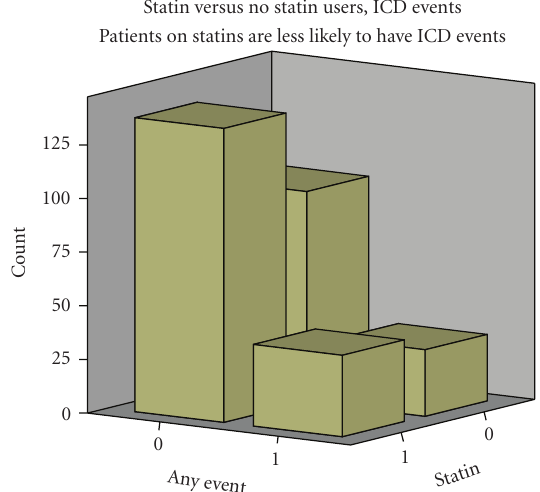
Figure 2: Comparison of events (any events = 1 versus no events = 0) by statin use ( = 1) or non-use ( = 0). Patients on statins are less likely to experience ICD